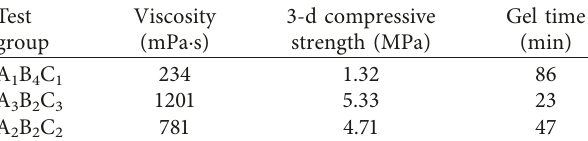
Table 7: Experimental results of the three kinds of materials.